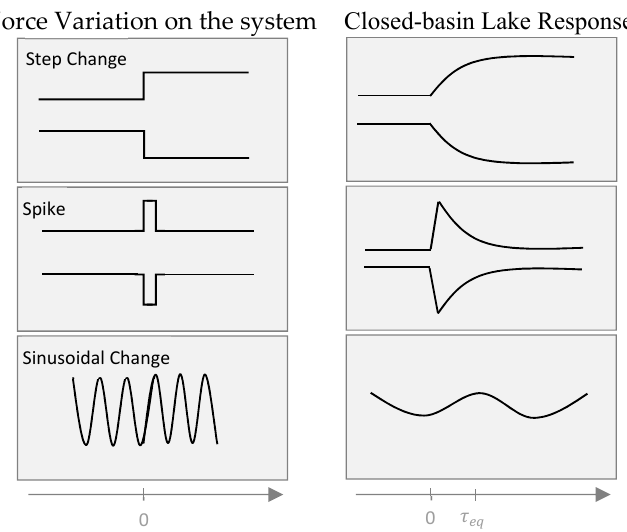
Figure 12. Illustration of closed-lake basin in equilibrium to climatic variation [34] (Reproduced with permission from [34]).